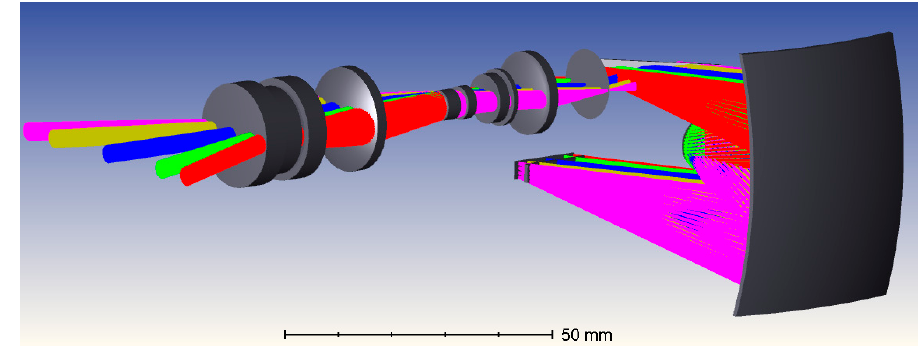
Figure 11. Integrated configuration of the spectrometer.